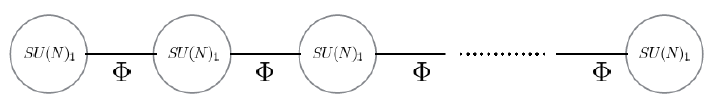
Figure 1 . A quiver theory that reproduces the phases of the (cid:18) -angle